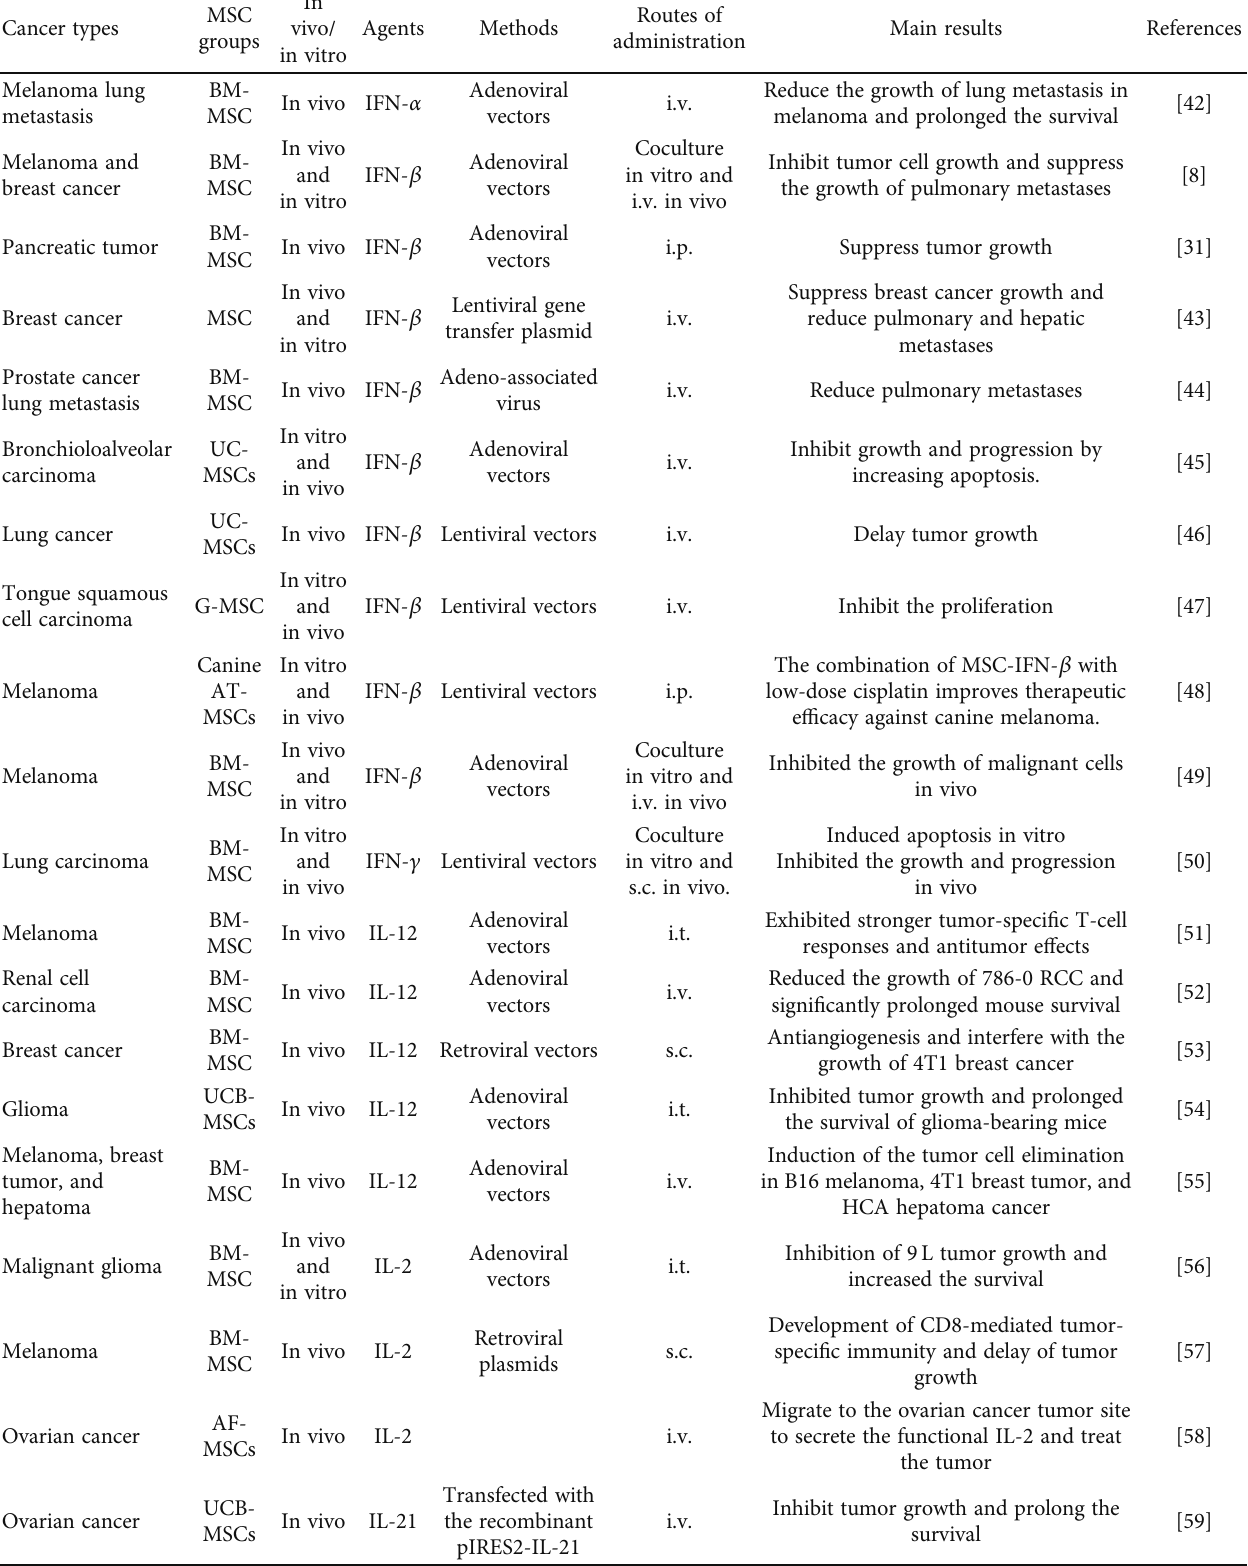
Table 2: MSCs as antitumor vectors of